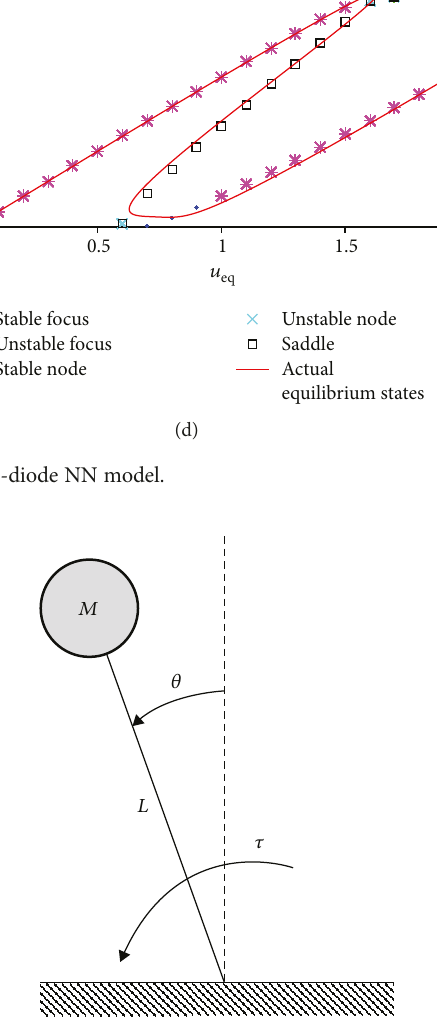
Figure 4: Inverted pendulum with